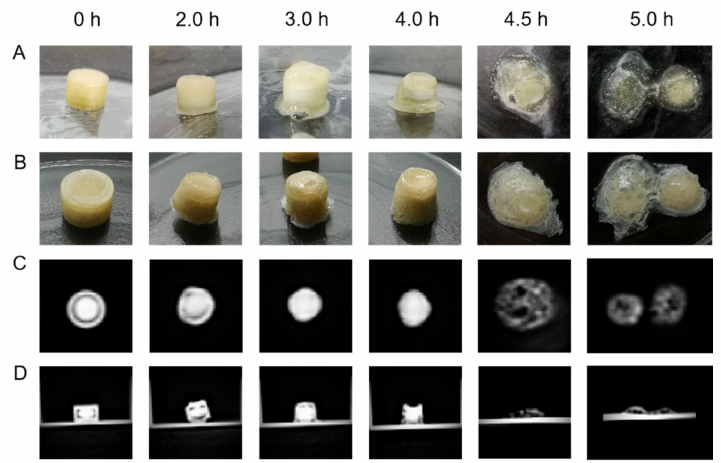
Figure 10. The changes of the 3D-printed tablets during dissolution: pictures of the tablet before ( A ) and after ( B ) freeze-drying process, CT images of cross section ( C ) and vertical section ( D ) of the